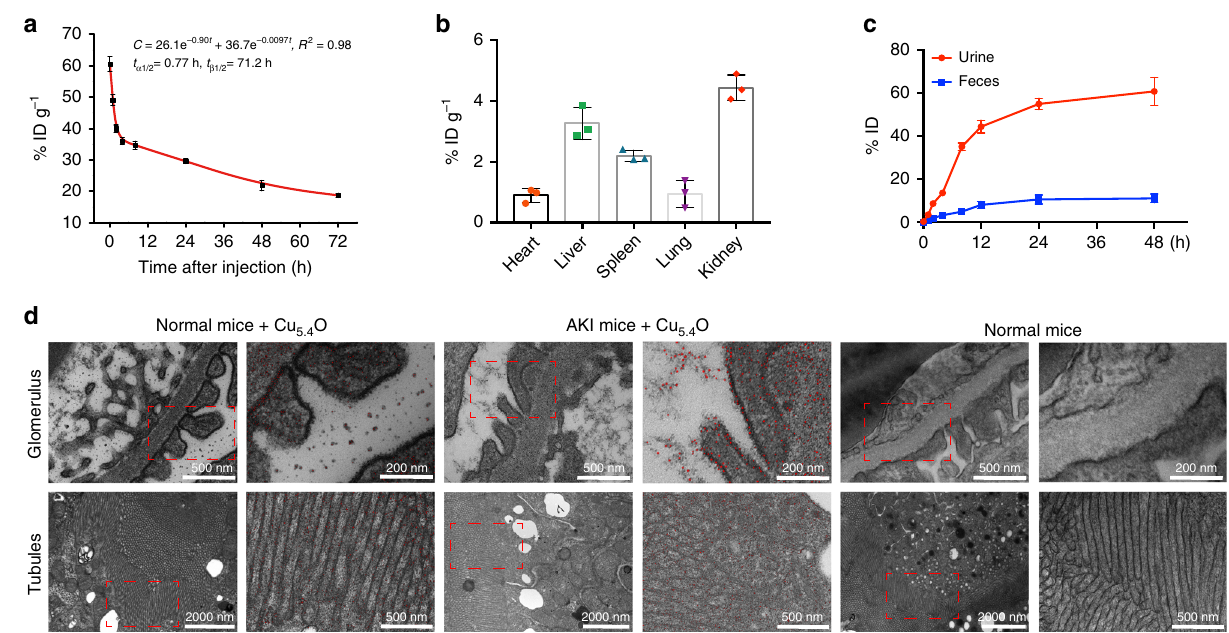
Fig. 6 Pharmacokinetics, biodistribution, and clearance of Cu 5.4 O USNPs in AKI mice. a In vivo blood pharmacokinetic curves after intravenous injection of Cu 5.4 O USNPs. b Biodistribution of Cu 5.4 O USNPs in major organs at 24 h post injection. c Cumulative urine and feces excretion at different time points. d Biodistribution of Cu 5.4 O USNPs in renal tissues by TEM observation. Red dashed lines indicate the magni fi ed area. Dots with red pseudocolor indicate Cu 5.4 O USNPs. In a – c , data represent means± s.d. from three independent replicates. Source data are provided as a Source Data fi